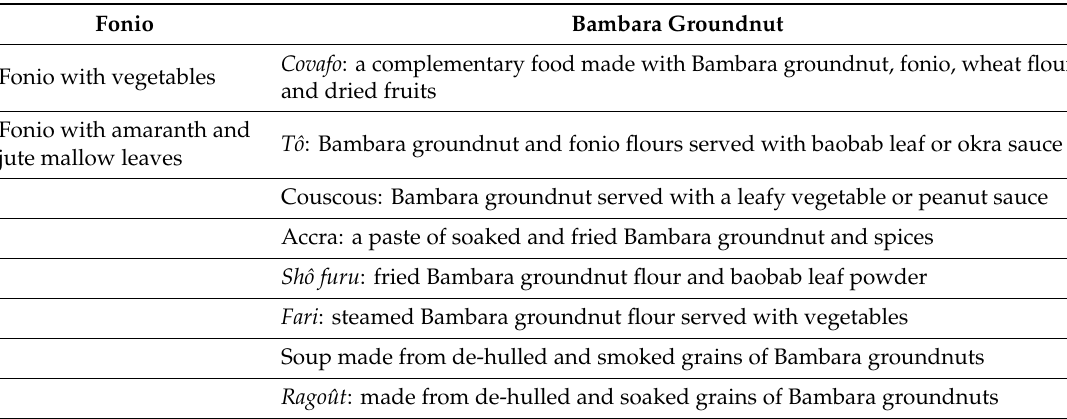
Table 4. Recipes and novel food products using orphan crops fonio ( Digitaria exilis ) and Bambara groundnut ( Vigna subterranea ) in nutrition interventions carried out by Bioversity and the Institut d’Economie Rurale (IER) in Mali. Fonio Bambara Groundnut Fonio with vegetables Fonio with amaranth and jute mallow leaves